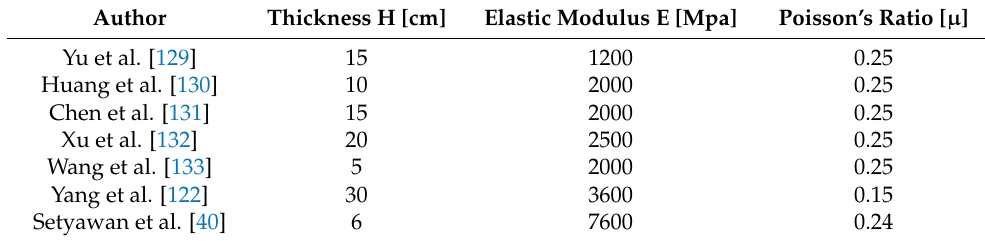
Table 13. Computational parameters of GSP in FEM.